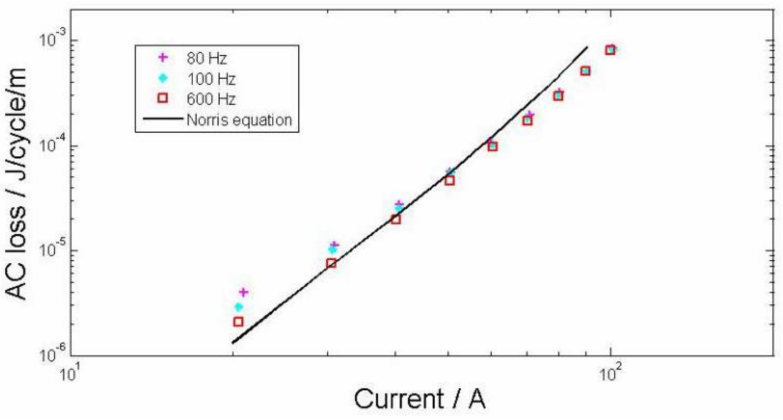
Figure 8. AC losses with non-insulated tape compared with the Norris equation.